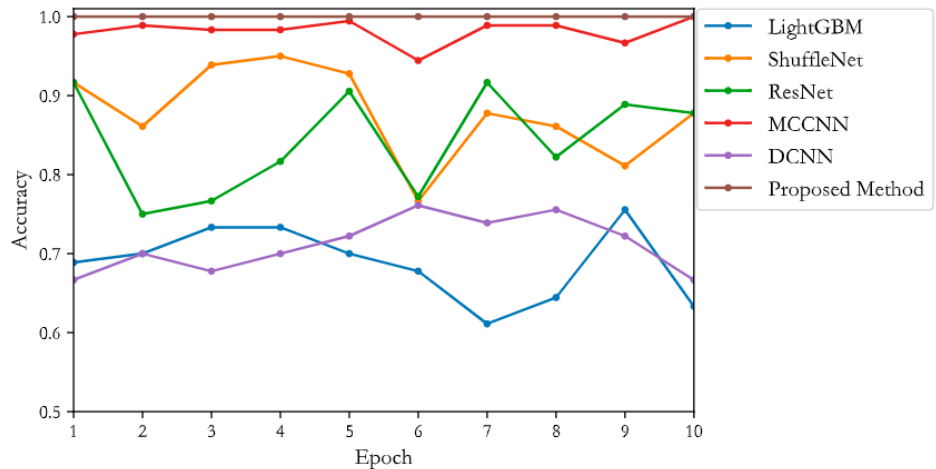
Figure 11. Comparisons between the different fault diagnosis methods. Table 3. Average accuracy and SD of the different methods.